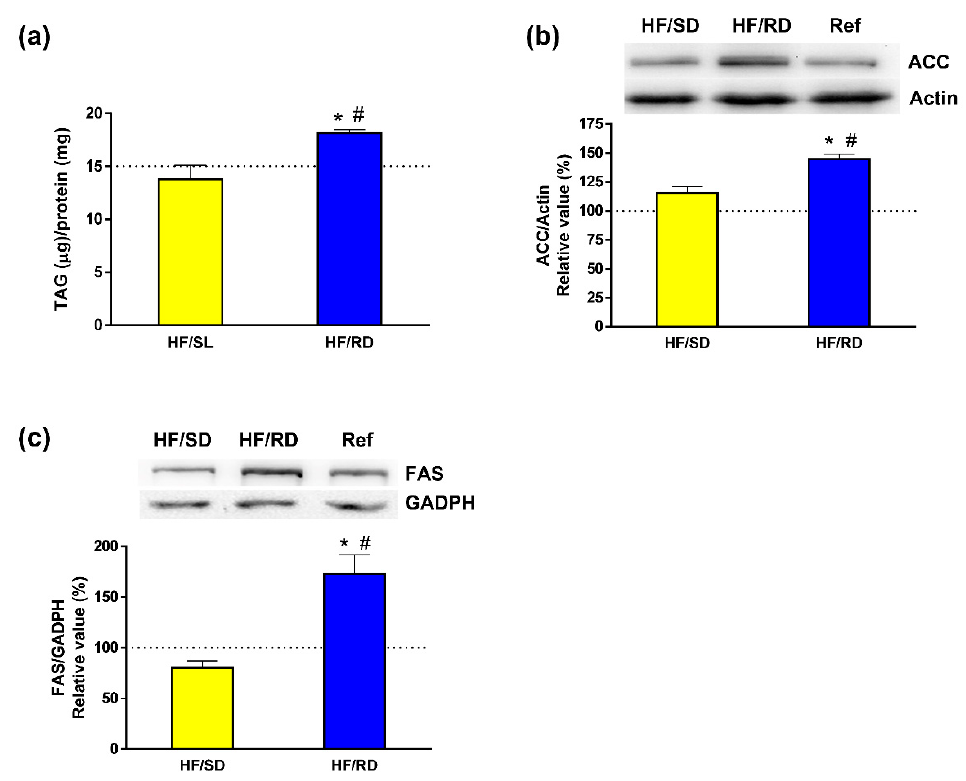
Figure 5. Liver lipogenesis. The expression of key enzymes has been analyzed by western blot, and liver triglyceride content has been assayed enzymatically. ( a ) Triacylglicerols (TAG) content. ( b ) Acetyl Coenzyme A carboxylase (AAC). ( c ) Fatty acid synthase (FAS). Results have been referred to control rats (100% value). Results are mean ± SEM ( n = 6 animals per group). * p < 0.05 compared to the HF–SD group; # p < 0.05 compared to the reference group.